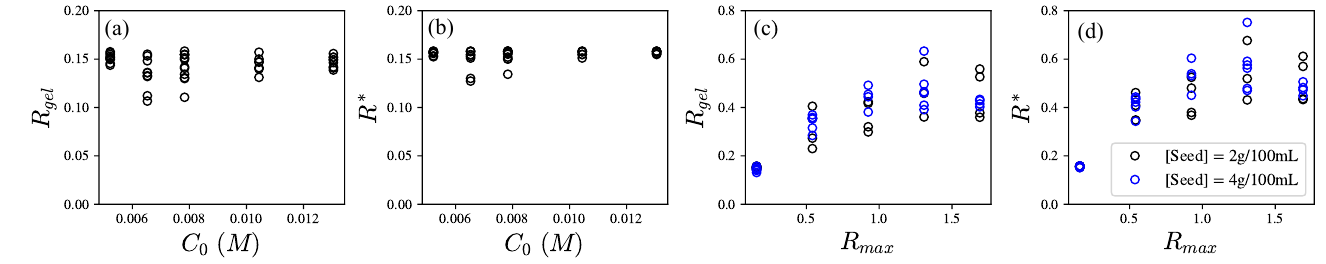
Figure 4. The predicted critical binding ratios R gel and R ∗ , determined from measured characteristic times for the respective GA ( C 0 ) and the calcium concentrations ( R max ). ( a , b ) show weak dependence of R gel and R ∗ on seed concentration for low R max while ( c , d ) show linear dependence of R gel and R ∗ on R max for R max < 1 and weak dependence of R gel and R ∗ on R max for R max >